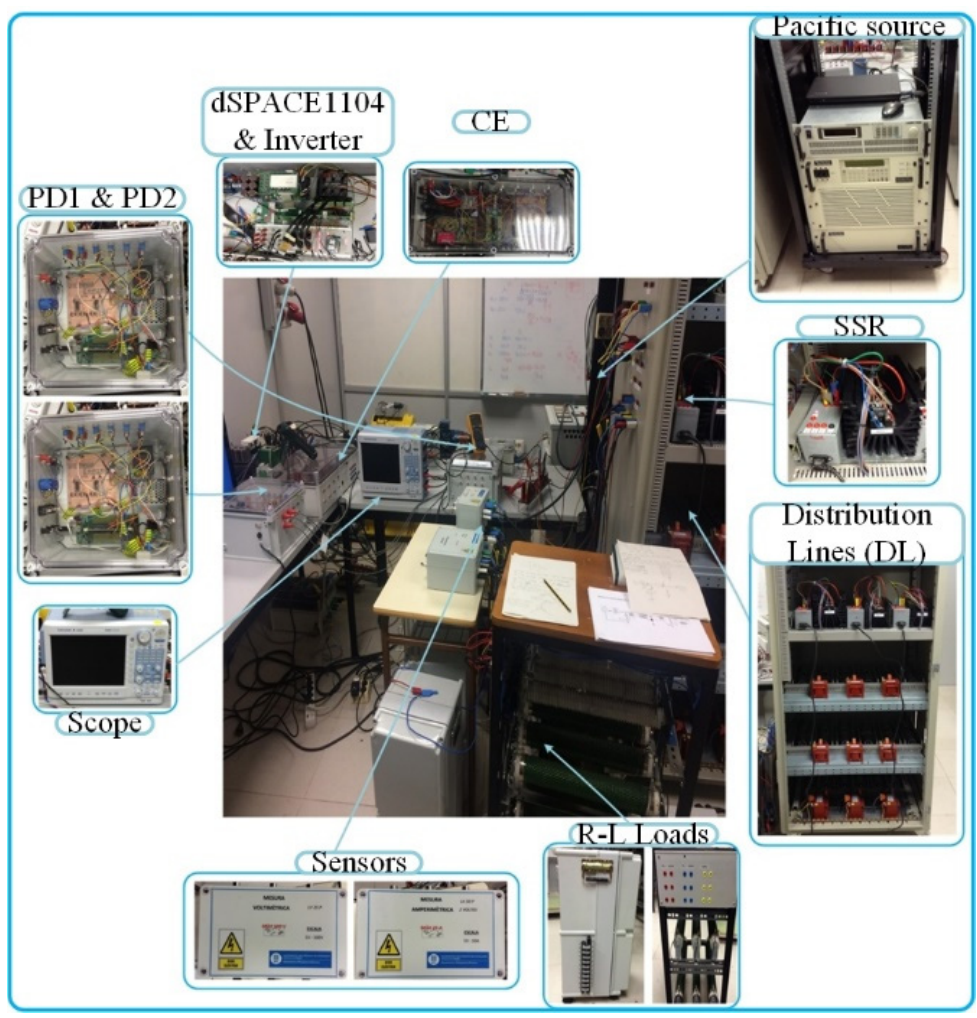
Figure 9. Complete laboratory setup. Table 4. System parameters.